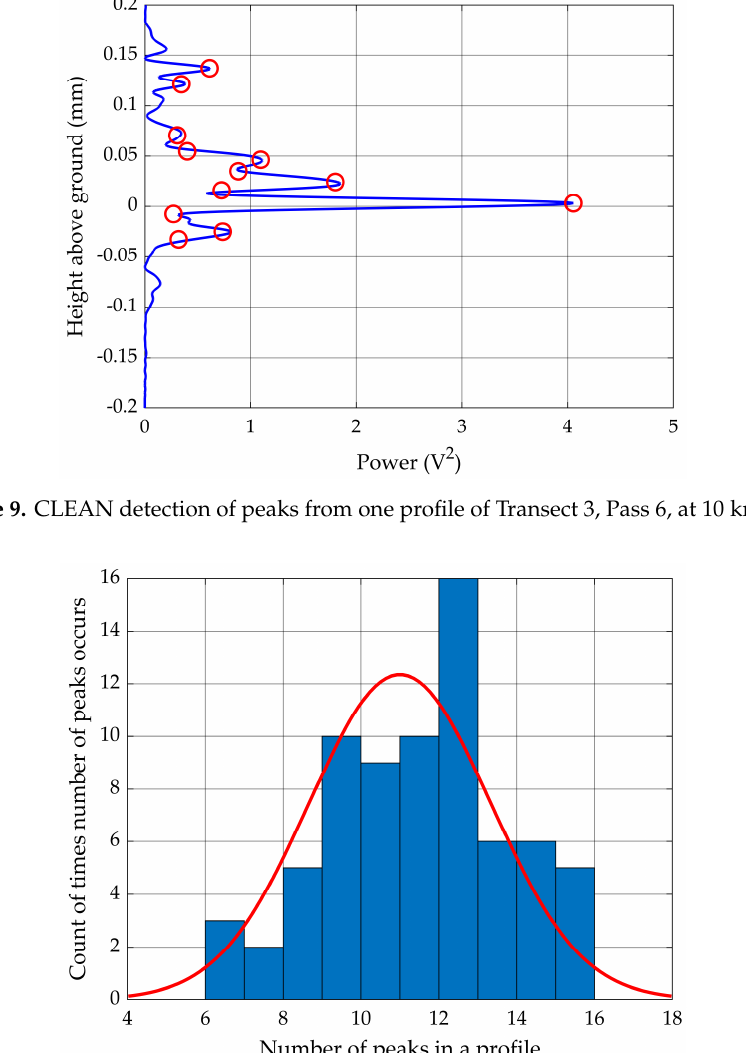
Remote Sens. 2019 , 11 , x FOR PEER REVIEW Figure 8 . A waterfall display of ultrasonic reflectivity profiles from Transect 3, Pass 6, at 10 km h -1 .